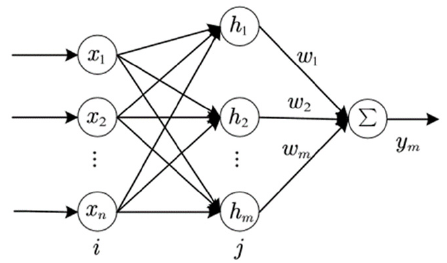
Figure 4. Structure of radial-based neural network. The network inputs the initial values of the position and speed of the maglev train: x = [ x 1 x 2 ] T . The neuron activation function of the hidden layer of the neural network consists of a radial-based function, and the array of arithmetic units, comprising the hidden layer, are called the hidden layer nodes. The hidden layer output of the neural network is h = [ h j ] T , where h represents the displacement limit of a magnetic levitation train, and the output expression of the implicit layer [23]